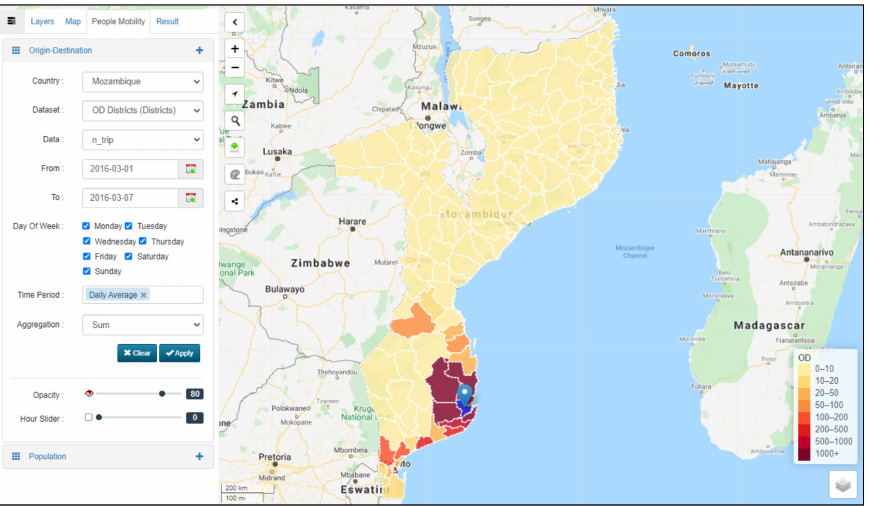
Figure 8. Visualization of the OD on a web map (blue indicates the origin, and the other color-range areas are the main destinations of the selected origin).